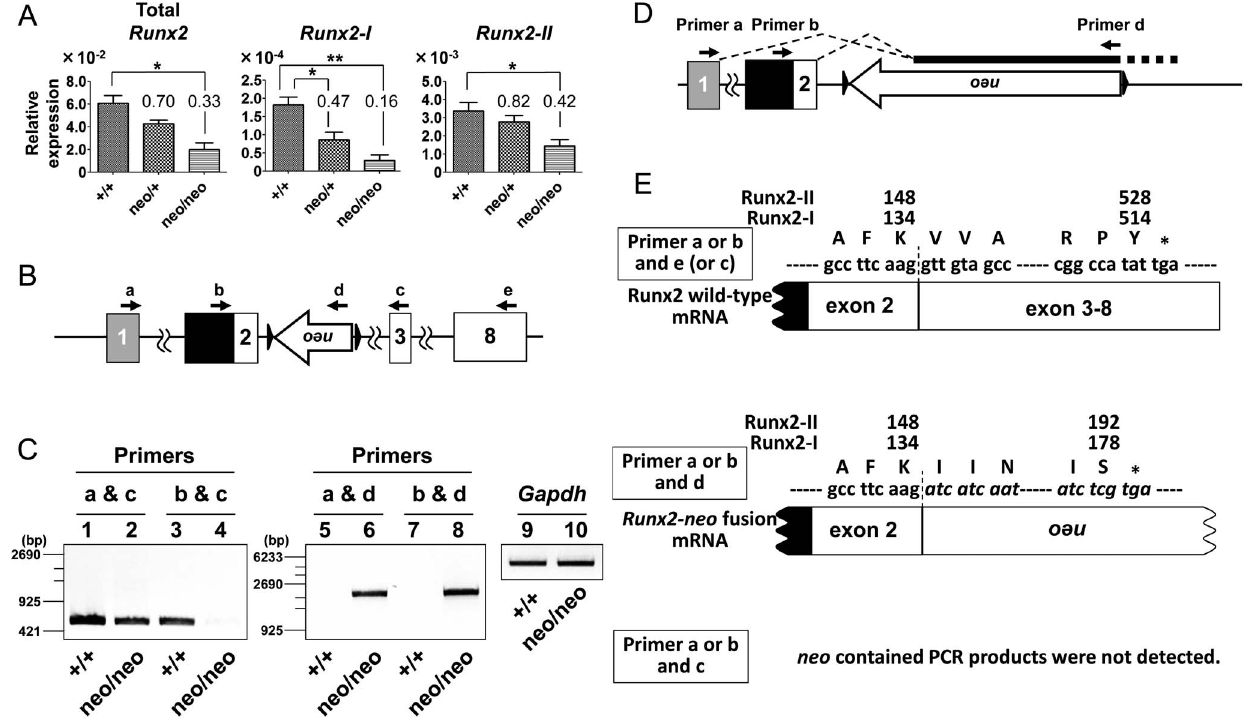
Figure 3. The neo transgene perturbed Runx2 expression. (A) Expression of total Runx2 , Runx2-I , and Runx2-II in Runx2-I -mutated mice. Expression was analyzed by quantitative real-time PCR using RNA prepared from E18.5 calvarial cells of wild-type ( + / + ), Runx2-I neo/ + (neo/ + ) and Runx2-I neo/neo (neo/neo) mice. The results were normalized against the expression of Gapdh . Data are representative of three independent experiments and are means 6 SEM ( n =3/group); * p , 0.05, ** p , 0.01. (B) PCR primers (arrows) were placed on Runx2 exons and the neo transgene. (C) Semiquantitative RT-PCR analysis of RNA prepared from E18.5 calvarial cells of wild-type ( + / + ) and Runx2-I neo/neo (neo/neo) mice by using the primer set depicted in panel (B). Gapdh was simultaneously amplified as an internal control (lanes 9 and 10). (D) Schematic diagram of alternative splicing pattern for Runx2 - neo fusion transcripts. (E) Sequences of the fusion transcripts and proteins. The nucleotide sequence shown in italics is from neo , and the asterisk indicates the stop codon in the reading frame. The amino acids corresponding to each codon, and their numbers in the sequence of each Runx2 isoform are also indicated.